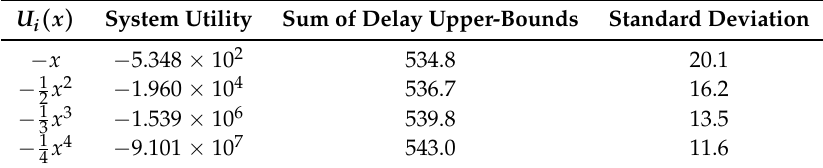
Table 1. The system utility, assigned intermediate deadline sum (i.e., total delay upper-bound) and standard deviation, with different utility functions, by solving the primal problem in Section 2.1.